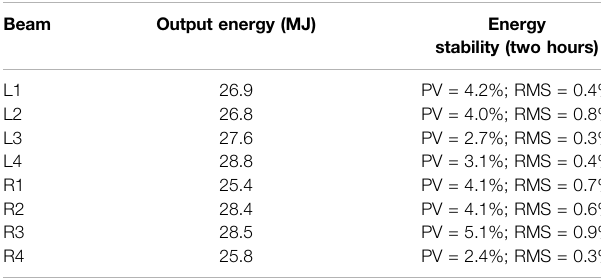
Figure 7 . The mode radii in the laser head (LH), lens (L), and cavity mirrors (CM1 and CM2) are 1.5, 1.75, 0.98, and 0.65 mm, respectively.